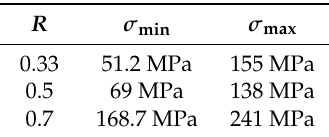
Table 3. Loading information for the a-N curves.